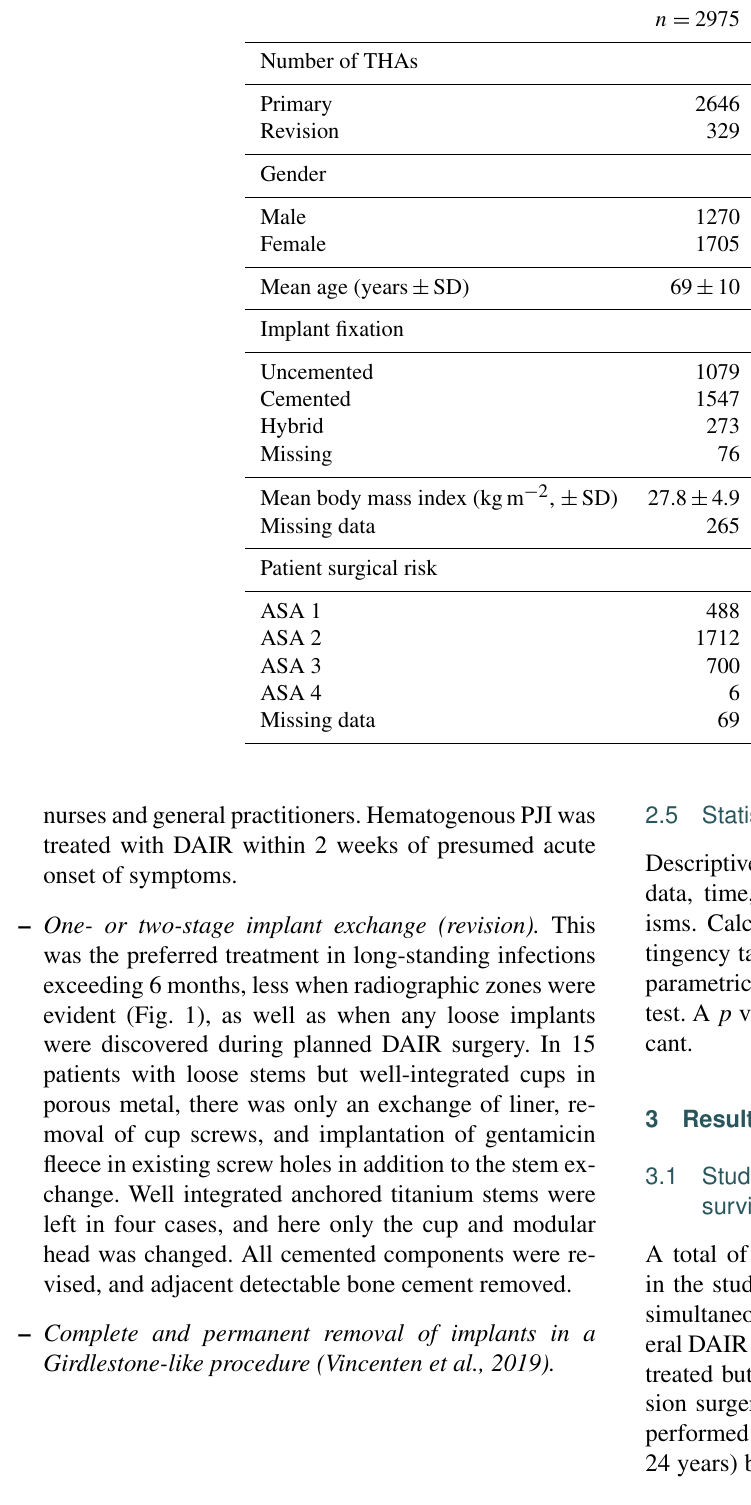
Table 1. Surgical data on patients undergoing THA (primary and revision) at our institution between 2012 and 2018 compared with the infected THA patients operated on during the same period and included in the study. Please note that 18 of the study patients were primarily operated on elsewhere and 20 additional patients were operated on prior to 2012. Surgical risk was defined according to the American Society of Anesthesiologists physical status classification (ASA). THA Infected THAs in study n = 2975 n = 51 Number of THAs Primary